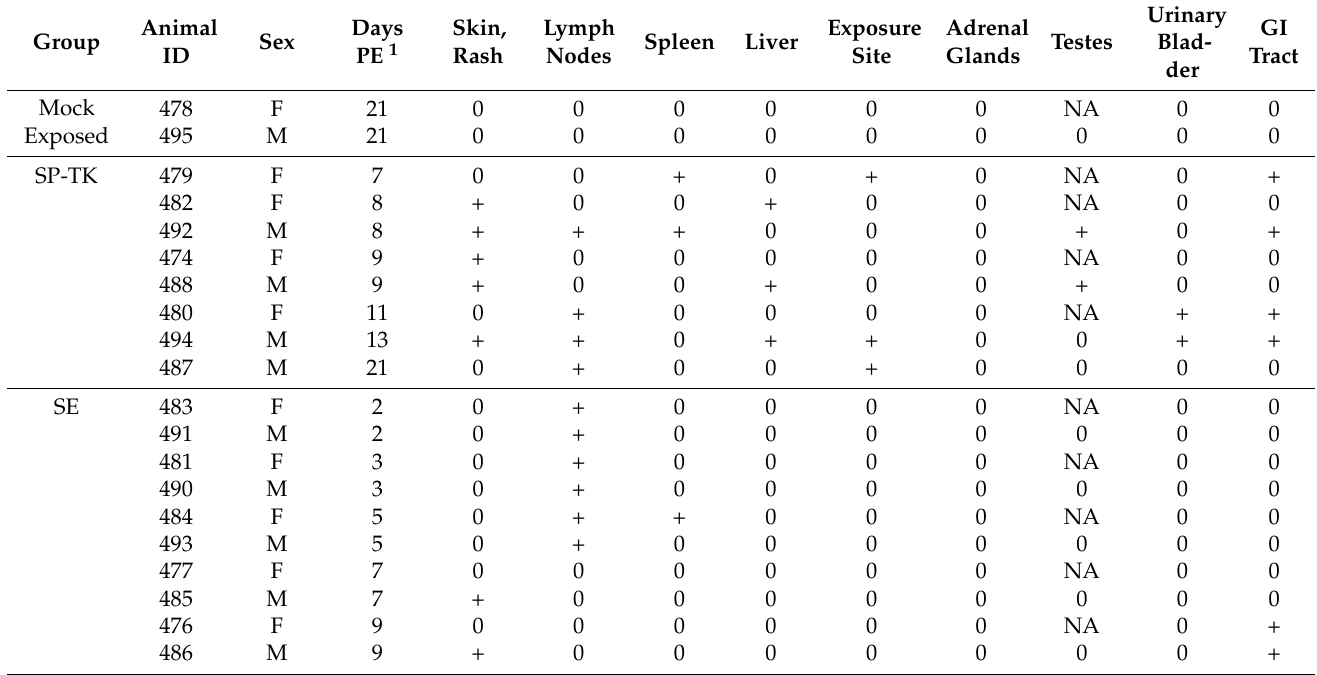
Table 7. SUDV-related Macroscopic